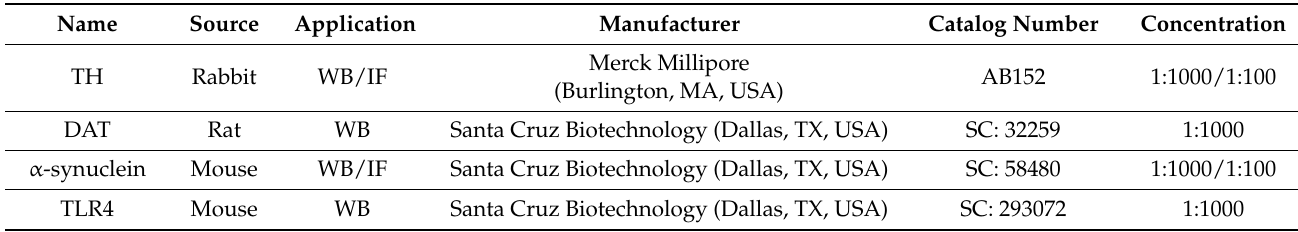
Table 1. List of antibodies used for Western blot and Immunofluorescence